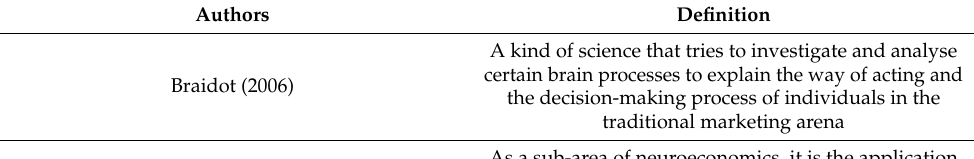
Table 1. Definitions of